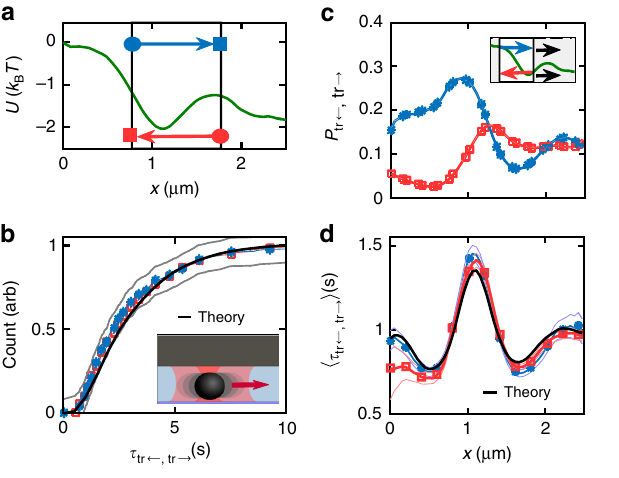
Fig. 3 Transition-path-time symmetry of particles in force landscapes. a Free energy U ( x ) calculated from inferred forces (see Methods). The standard error of the mean (not shown) is smaller than the line thickness. by the black box in a (compare with Fig. 1b). Kolmogorov – Smirnov test boundaries are plotted in light grey. c Transition probabilities across a 1 μ m region, which is continuously moved along x . The standard error of the mean (not plotted) is on the order of the marker size. d Transition-path times over the same spatial interval. Error envelopes show the standard error of the mean. While the lines in b – d show the full data set, the markers only highlight selected data points